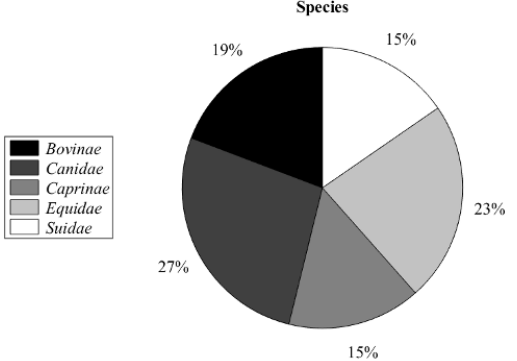
Figure 1. Percentage of phytoectoparasiticides use by different animal species.